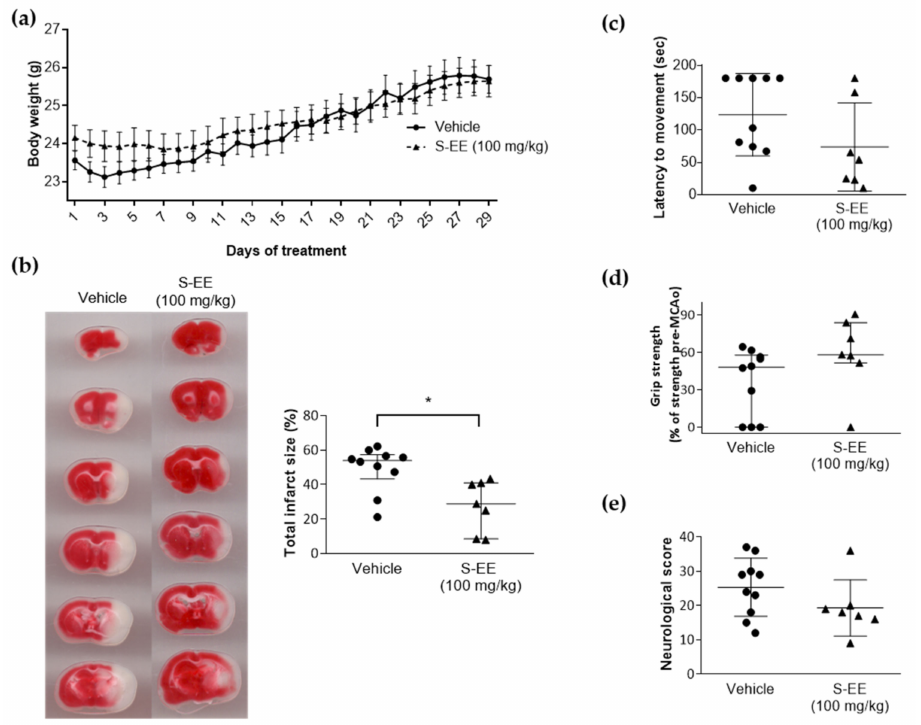
Figure 3. Effect of oral supplementation with S-EE for 28 days on experimental strokes in mice. ( a ) Daily bodyweight monitoring after 28 days of treatment with S-EE or vehicle. ( b ) Represen- tative images of TTC brain staining and quantification of percentage of infarct volume 24 h after t-pMCAo. Neurological and functional evaluation were performed 24 h after surgery including latency–movement test ( c ), grip strength test ( d ) and neurological score ( e ). Sample size: vehicle n = 10; S-EE n = 7. Data were analyzed using Student’s t-test. * p < 0.05 vs.